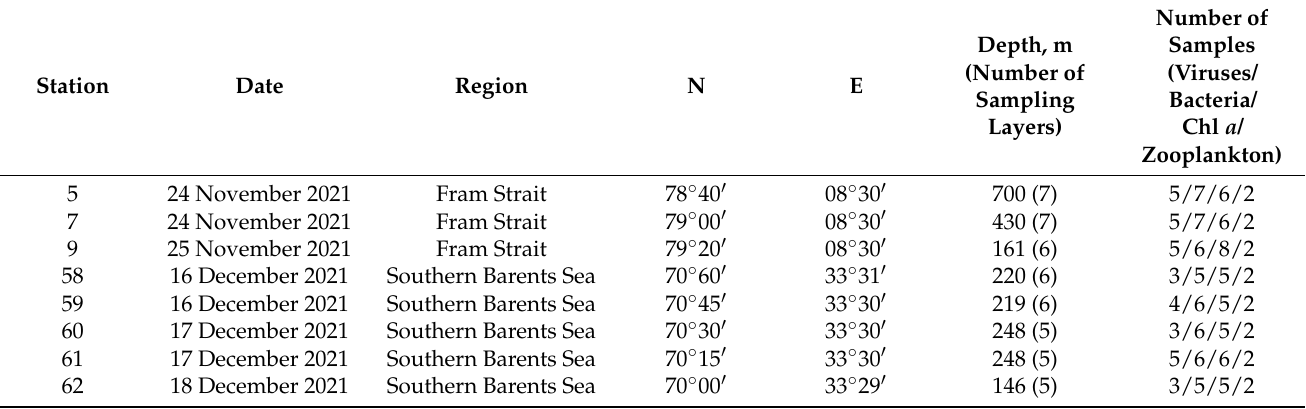
Table 1. List of sampling stations in the Fram Strait and in the Southern Barents Sea, winter